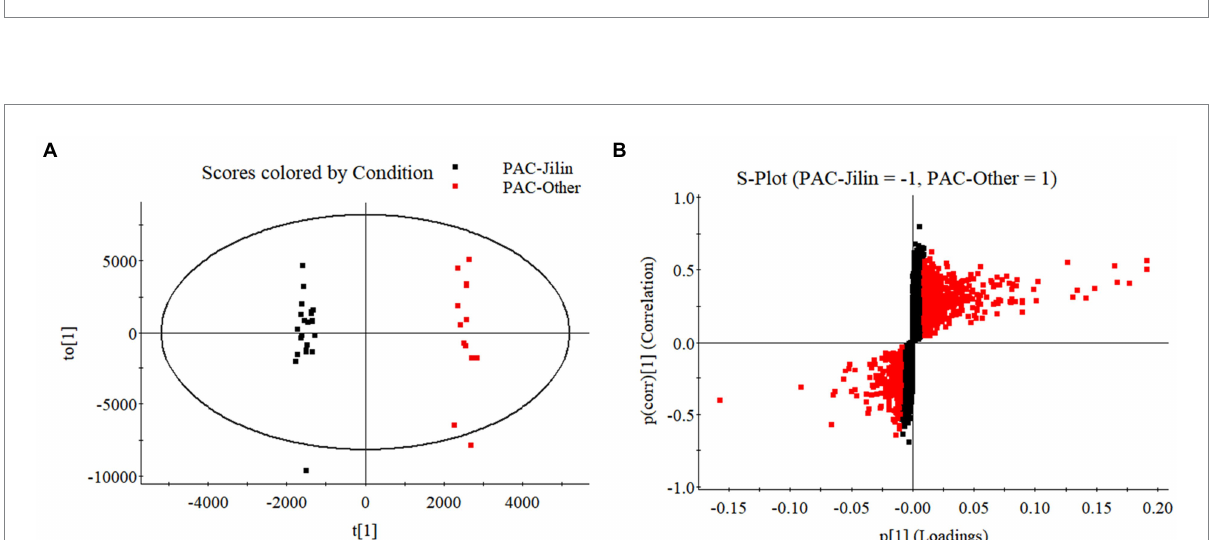
FIGURE 8 The OPLS-DA models distinguished geographically diverse calyxes of P. alkekengi . (A) The OPLS-DA models distinguished P. alkekengi . calyxes from Jilin and other proviences. (B) The S-Plot of potential distinguishing compounds.